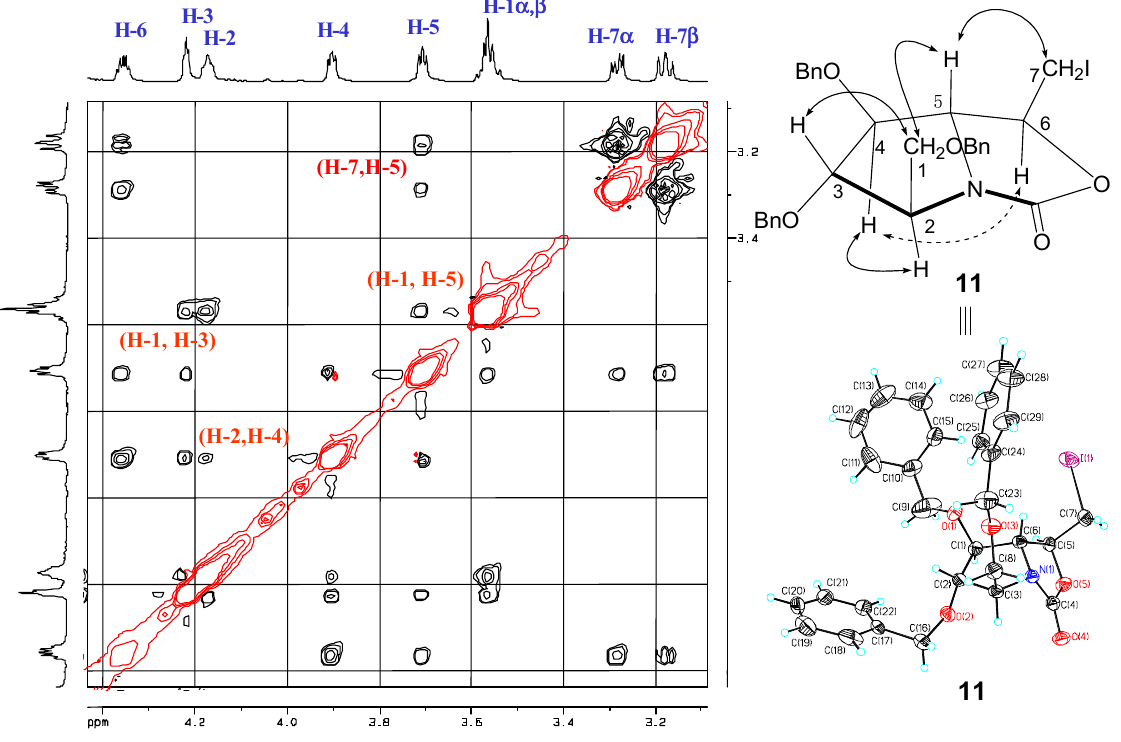
Figure 2. Stereochemistry elucidation of 11 by NOESY and X-ray